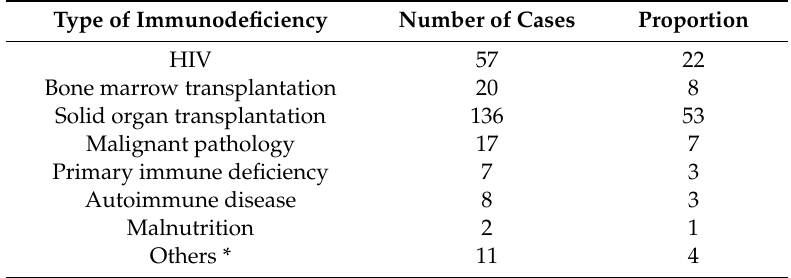
Table 1. Distribution of immunodeficiency in cryptosporidiosis cases from 2017 to 2019 in France.